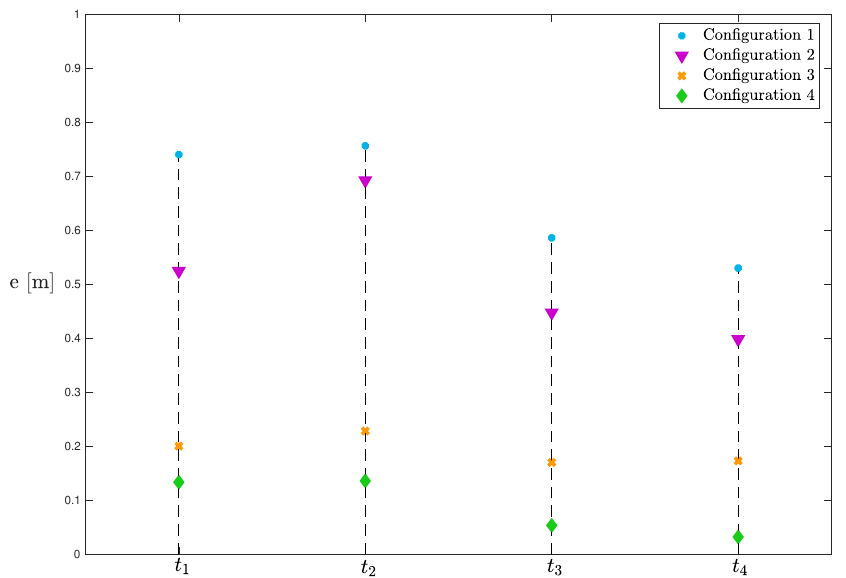
Figure 2. Values of the average localization error e for the four considered positions of the TN ( t 1 , t 2 , t 3 , and t 4 ) obtained in Configuration 1 (light-blue dots), Configuration 2 (violet triangles), Configuration 3 (orange crosses), and Configuration 4 (green diamond).